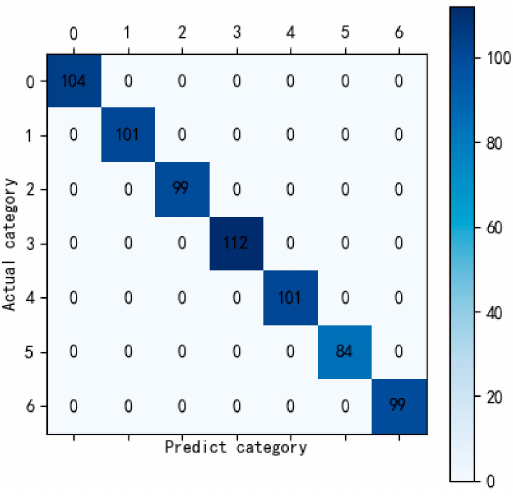
Figure 4. The confusion